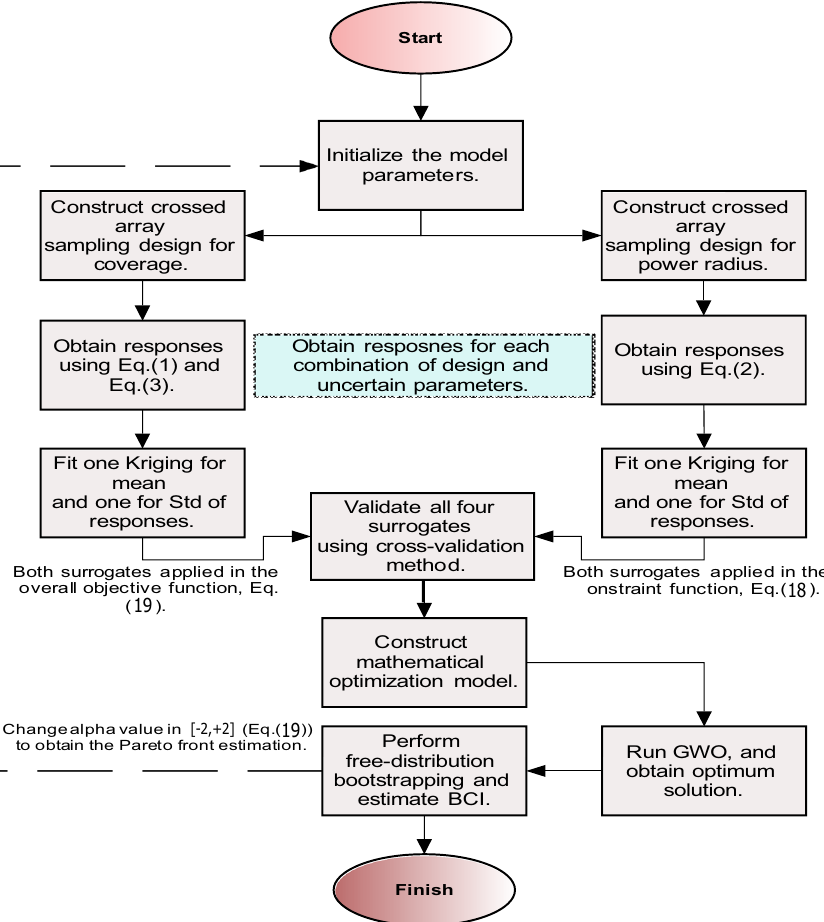
Figure 3. The proposed algorithm for multiple transmitter placement problem under uncertainty. In the proposed algorithm, two set of experiments are designed regarding the crossed array design, by setting decision variables in an inner array and uncertain variables in an outer array. Two surrogates are fitted, one over mean and another over Std of coverage. Another crossed array design constructed with the same framework for power radius.